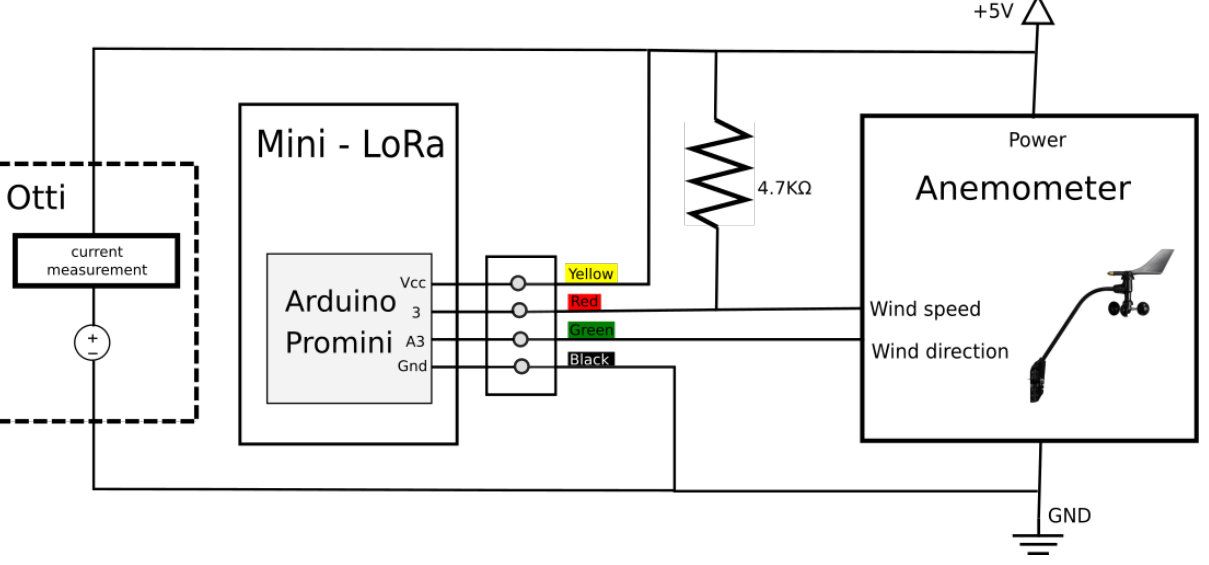
Figure 3. Anemometer connection